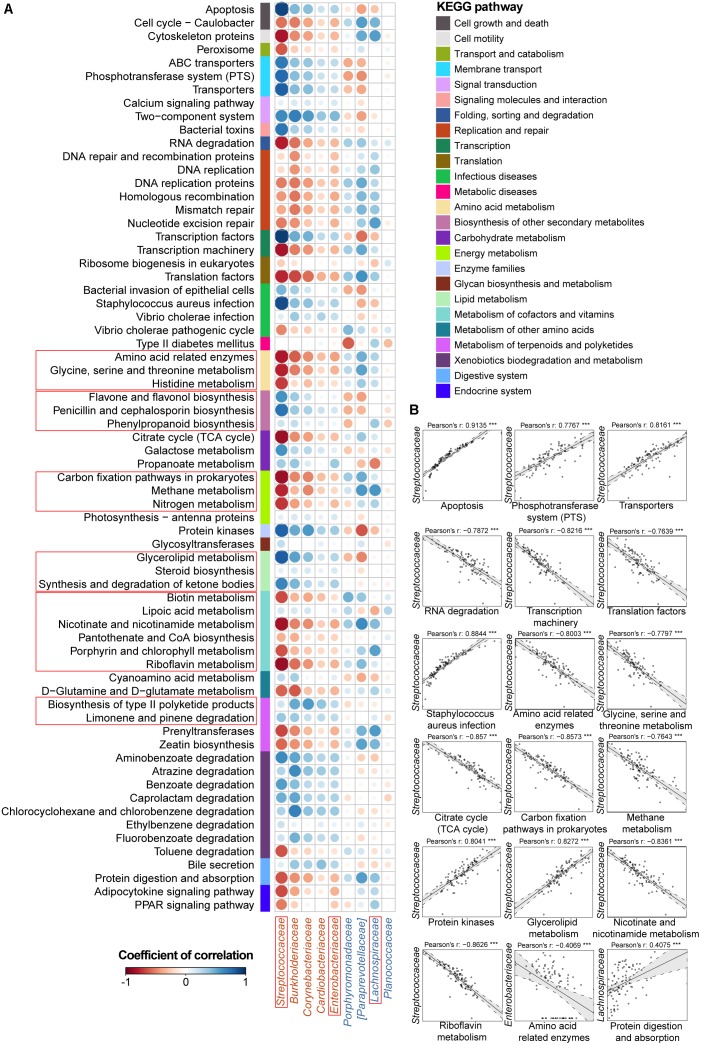
Associations between altered families and functions in the UC microbial community with reference to HCs. (A) Pearson’s correlation array between the family and functional variables. Functional pathways were predicted from an OTU table using the PICRUSt algorithm with references from the KEGG database. Differentially abundant highest-detail pathways and families between the UC and HC groups based on the Wilcoxon rank-sum test are listed in rows and columns, respectively. Colored bars adjacent to the highest-detail pathways indicate corresponding upper pathways. The colors of the circles represent the directions of the correlations, and their sizes correspond to the significance of the P-values (the larger the circle, the smaller the P-value and thus, the higher the significance). (B) Individual correlations of Streptococcaceae, Enterobacteriaceae and Lachnospiraceae with correlation coefficients ≥ 0.4 or ≤ -0.4 and their P-values are shown (∗∗∗ indicates P < 0.001, ∗∗ indicates P < 0.01, and ∗ indicates P < 0.05). The line in each correlation indicates the fitted linear model, and the gray area within the dashed lines shows the 95% CI for that model.